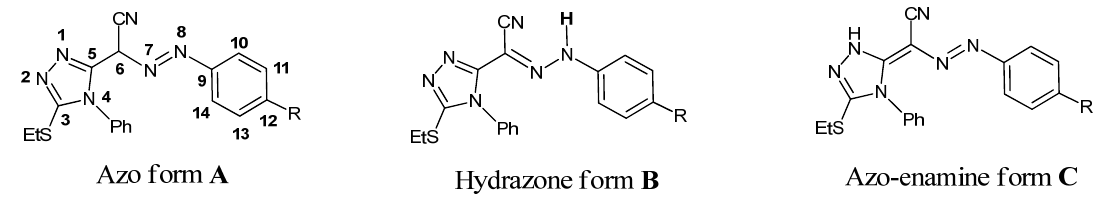
Table 1. Tautomer ratios in the solid state and in CDCl